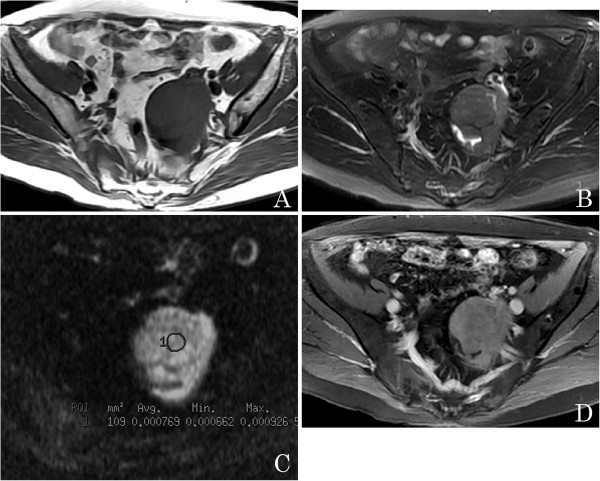
A 63-year-old woman with a left ovarian cystadenocarcinoma. (A) An axial T1-weighted image shows a left pelvic mass with isointensity. (B) Axial T2-weighted image reveals that the mass is a solid tumor with low signal intensity. (C) Axial diffusion-weighted imaging (DWI) obtained at b = 1,000 s/mm2 reveals the solid tumor as hyperintense with a lower apparent diffusion coefficient (ADC) value (circle 1, ADC = 0.769 × 10-3 mm2/s). (D) Axial contrast-enhanced T1-weighted image demonstrates marked enhancement of the solid part.